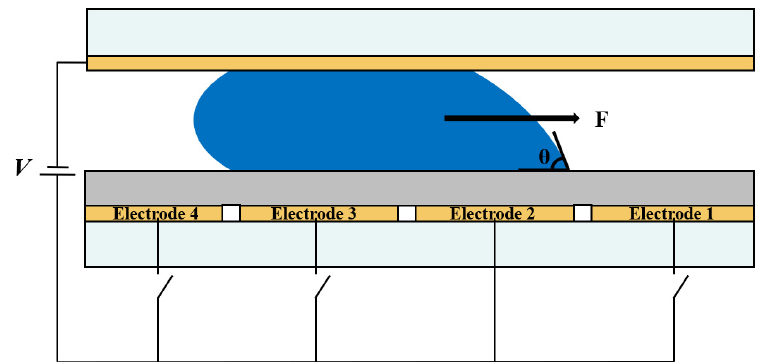
Figure 2. Schematic diagram of force on oil movement driven by electrowetting. By activating electrode 2, the contact angle θ is reduced and the droplet is deformed accordingly. The electric field force drives the whole droplet toward the